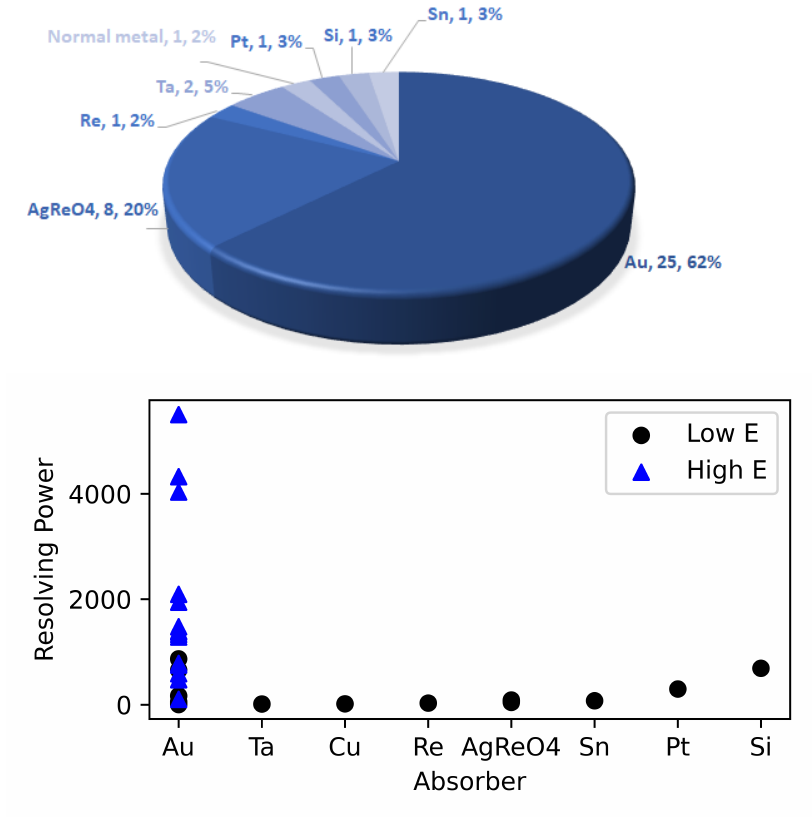
Figure 5. Absorber materials used in Decay Energy Spectroscopy. The resolving power can be seen as a function of absorber material for both high energy DES and low energy DES measurements.